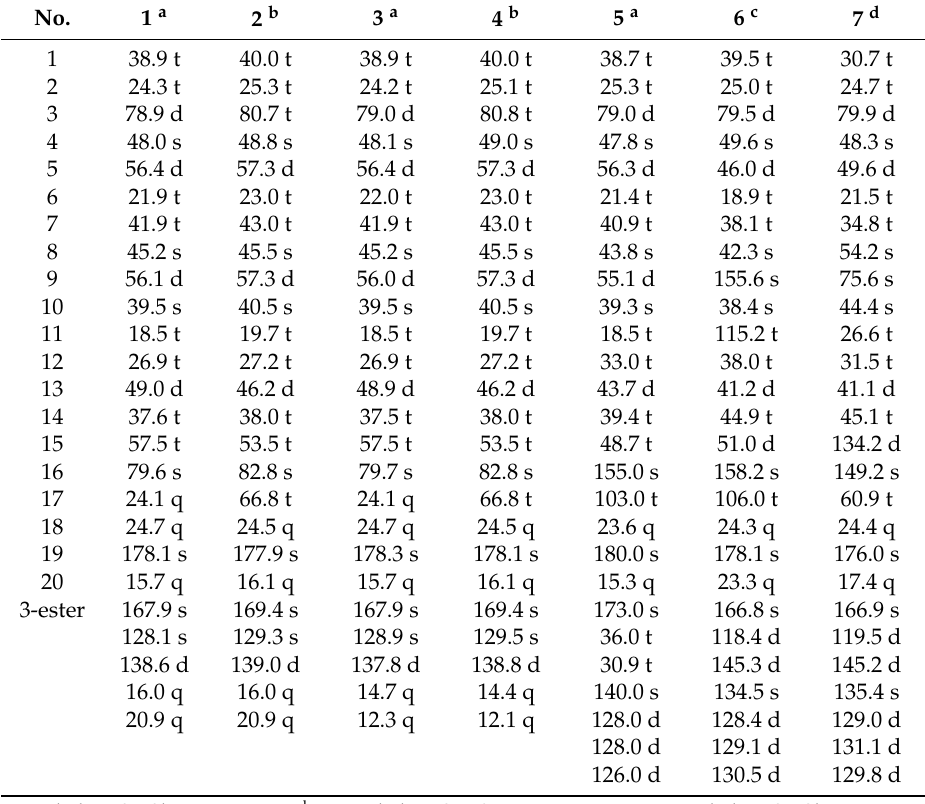
Table 2. 13 C-NMR Data for Compounds 1 – 7